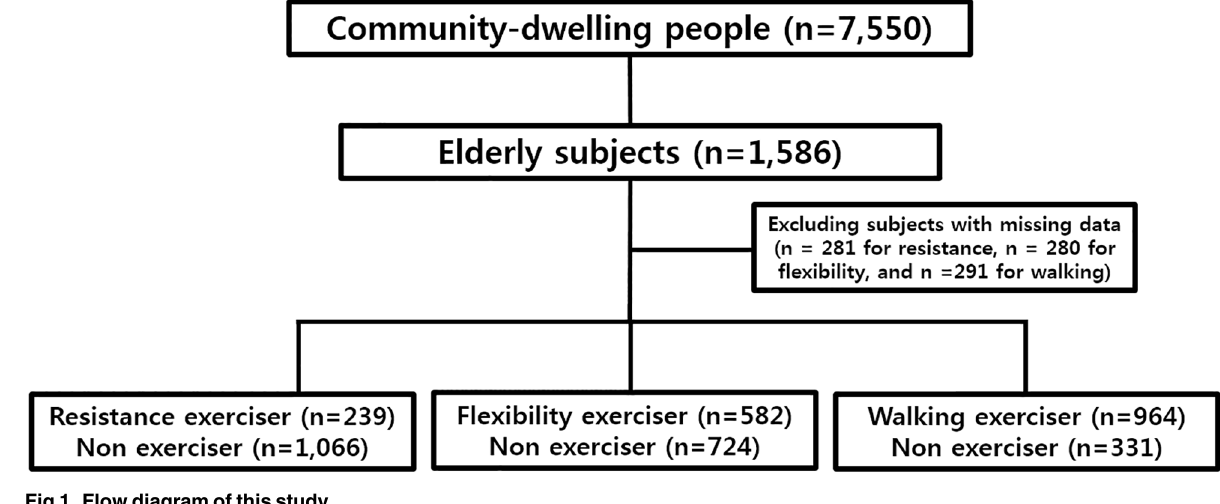
Fig 1. Flow diagram of this study.